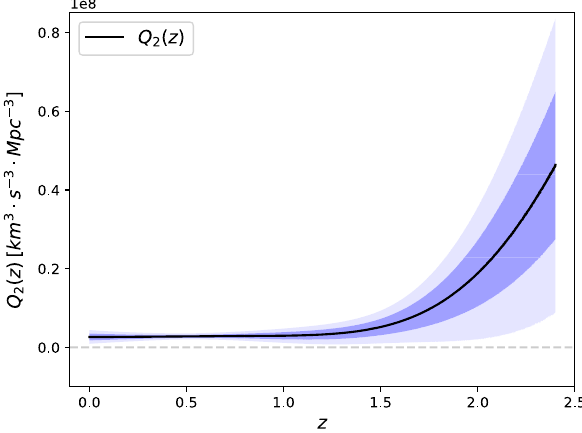
Fig. 4 Reconstruction of Q 2 ( z ) via GP and MCMC from OHD (Table 1). The black line is Q 2 ( z ) . The blue bands show 1 σ and 2 σ regions of reconstruction. The gray dashed horizontal line shows the value of zero. Note that the value of Q 2 ( z ) is greater than zero by more than 2 σ at any redshift within z ∈ [ 0 , 2 . 4